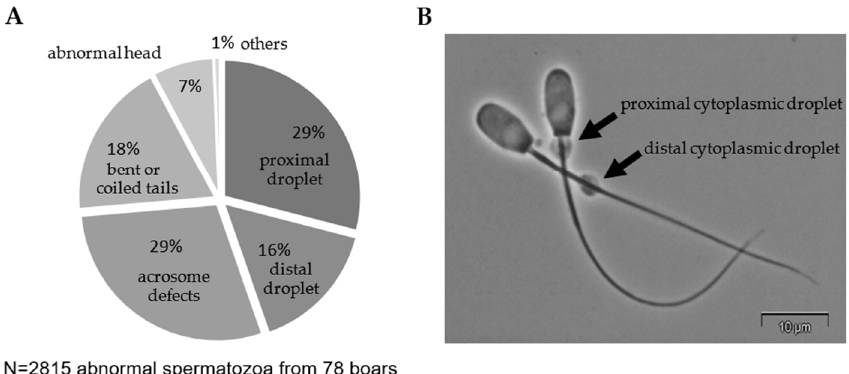
Figure 2. Morphological defects in short-term stored semen samples. ( A ) Distribution of sperm defects in the samples analyzed after 24 h storage at 17 °C. In case of multiple abnormalities per spermatozoon, only one defect was assigned to the cells. The hierarchy for scoring sperm defects was: (1) multiple sperm parts (e.g., two tails), (2) loose heads, (3) acrosome defects (e.g., detached acrosome), (4) head abnormalities (e.g., tapered head), (5) abnormalities in the neck, mid-piece, principal, and end piece (e.g., bent tails), and (6) cytoplasmic droplets. ( B ) Exemplary phase-contrast image of boar spermatozoa with either a proximal or a distal cytoplasmic droplet.